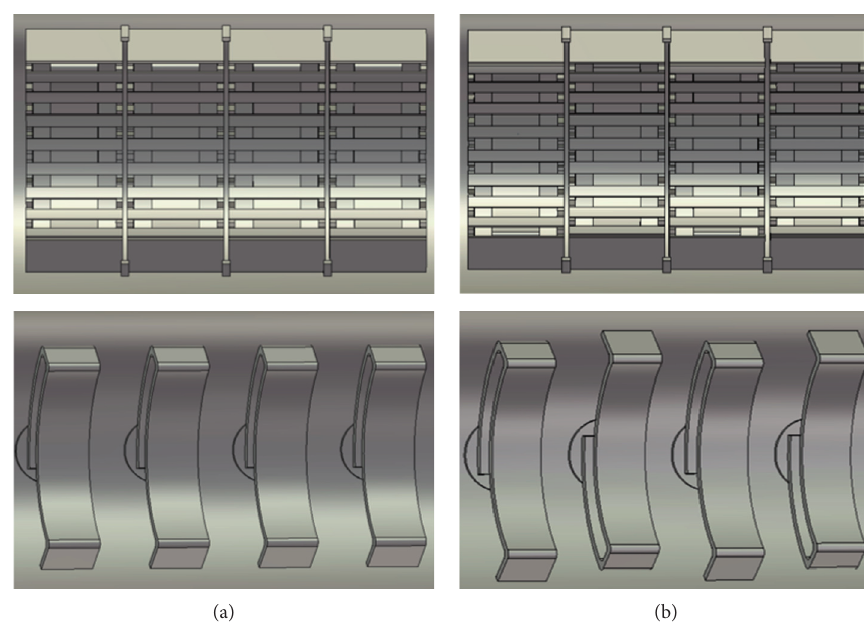
Figure 6: Original FS and strap array (a) and FS and strap array after optimization (b).